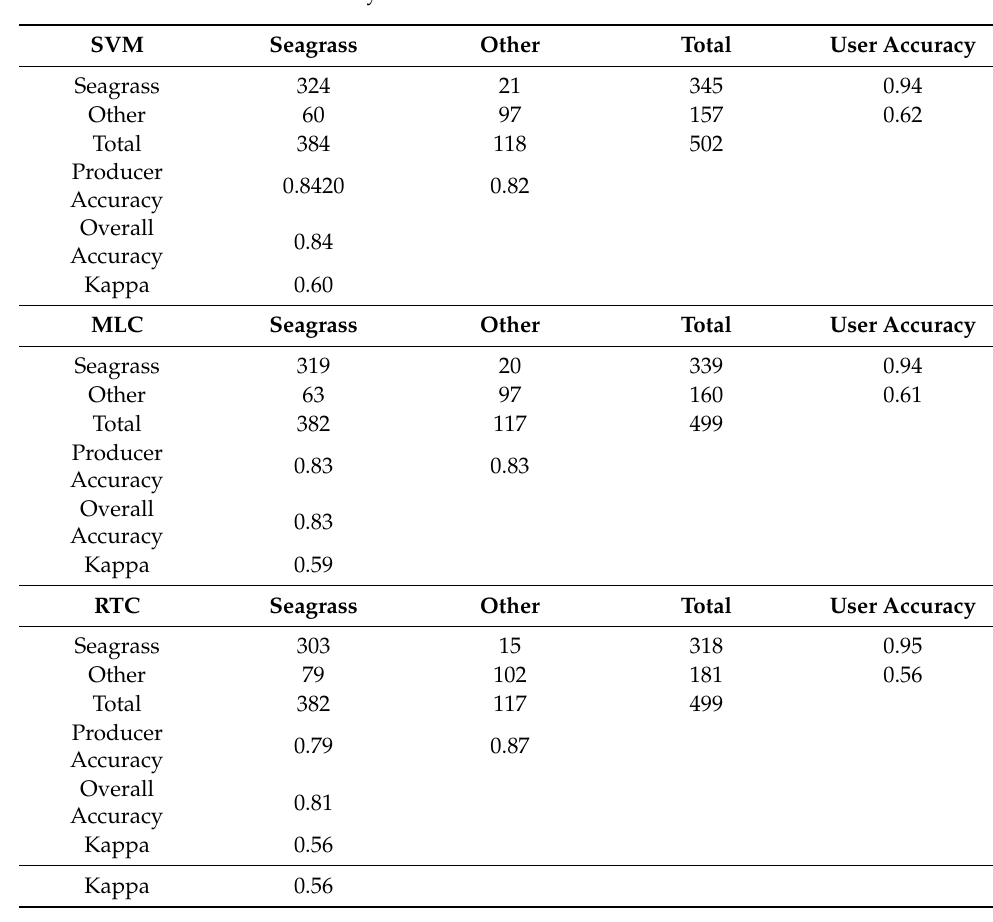
Figure 3. Bathymetry versus log-transformed water surface reflectance for bands 2 (R w = 490), 3 (R w = 560) and 4 (R w = 665) ( a ) and spectral dependence of diffuse attenuation coefficient for water surface reflectance values for bands 2 (R w = 490), 3 (R w = 560) and 4 (R w = 665) ( b ). Values of attenuation coefficient are in meters because they are depth-specific, since reflectance values are unit-less. Table 1. Confusion matrix